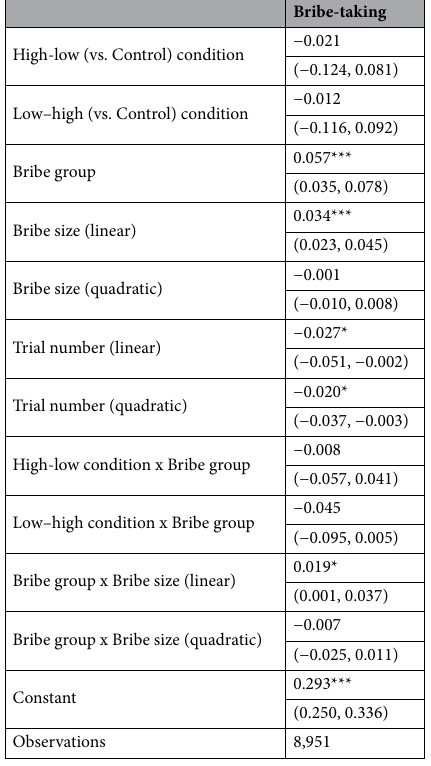
Table 1. The results of Study 1. The numbers in parentheses represent 95% confidence intervals around the regression coefficients. Random effects are not shown for simplicity. * p < 0.05, ** p < .0.01, *** p < 0.001.